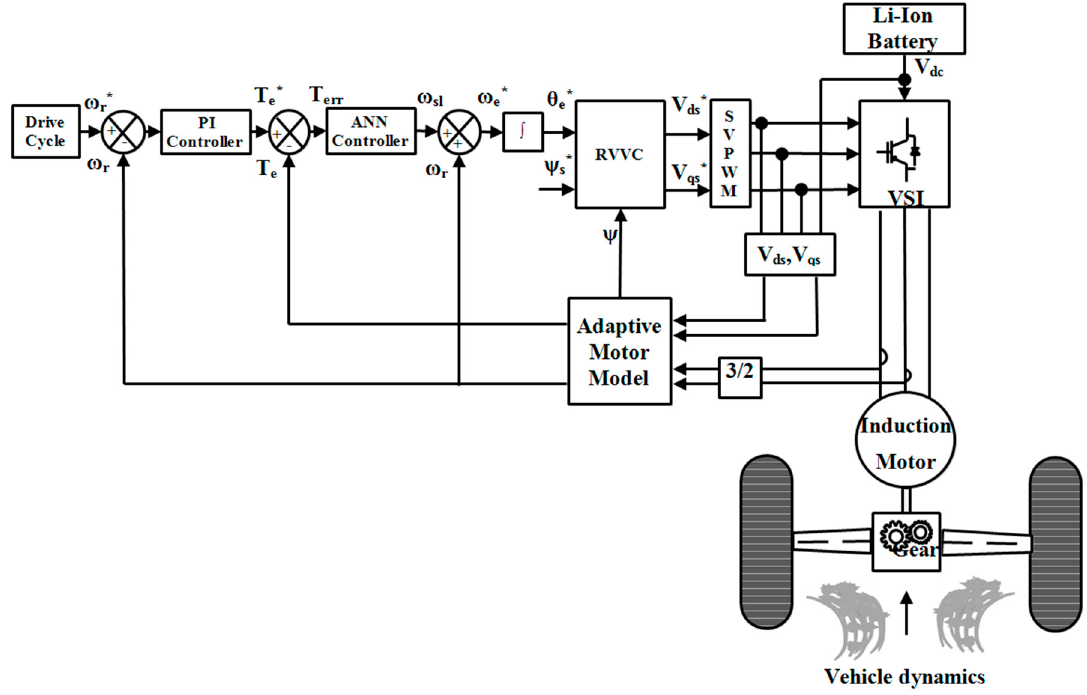
Figure 8. Adaptive neural network ( ANN) based direct torque controlled eCAR propulsion system.